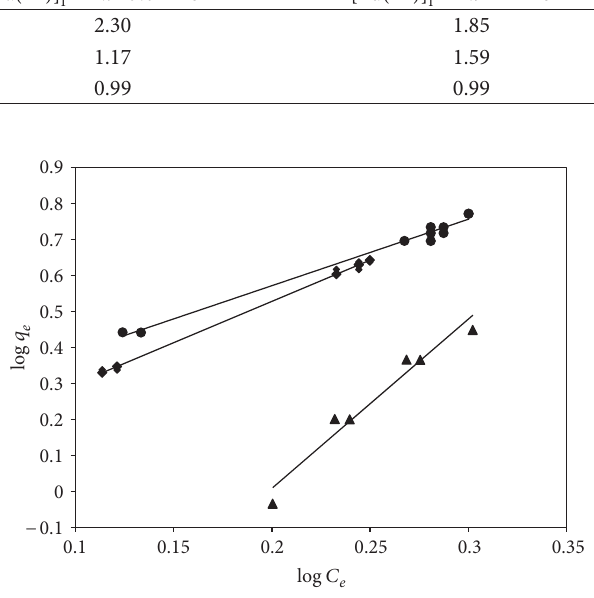
F 5: Isotherms of Freundlich model with on synthetic hydroxyapatite. e equations of the lines are: